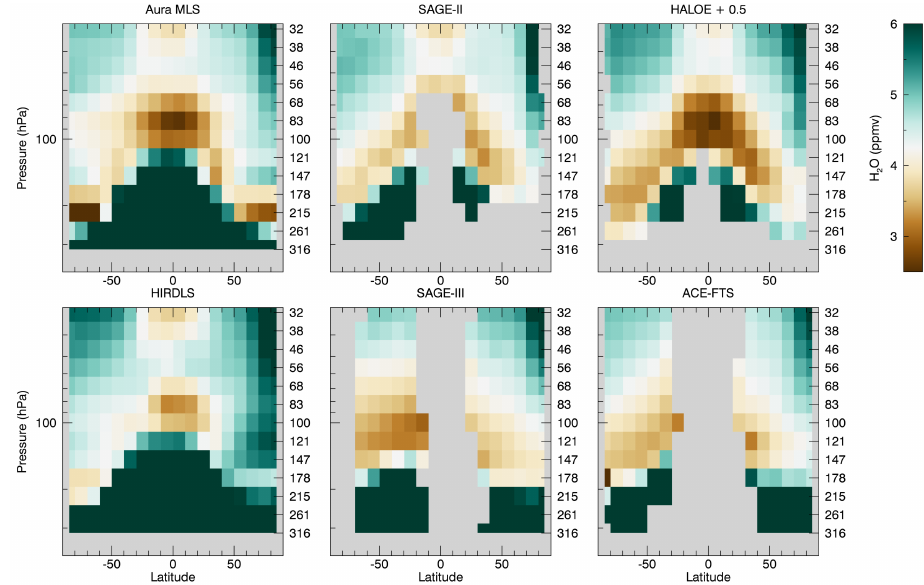
Figure A2. Zonal-mean height vs. latitude cross section of water vapor from six satellite instruments for the month of March, averaged from 2001 to 2009. Data are gridded on a 10 ◦ latitude grid using PV-based equivalent latitude from MERRA.